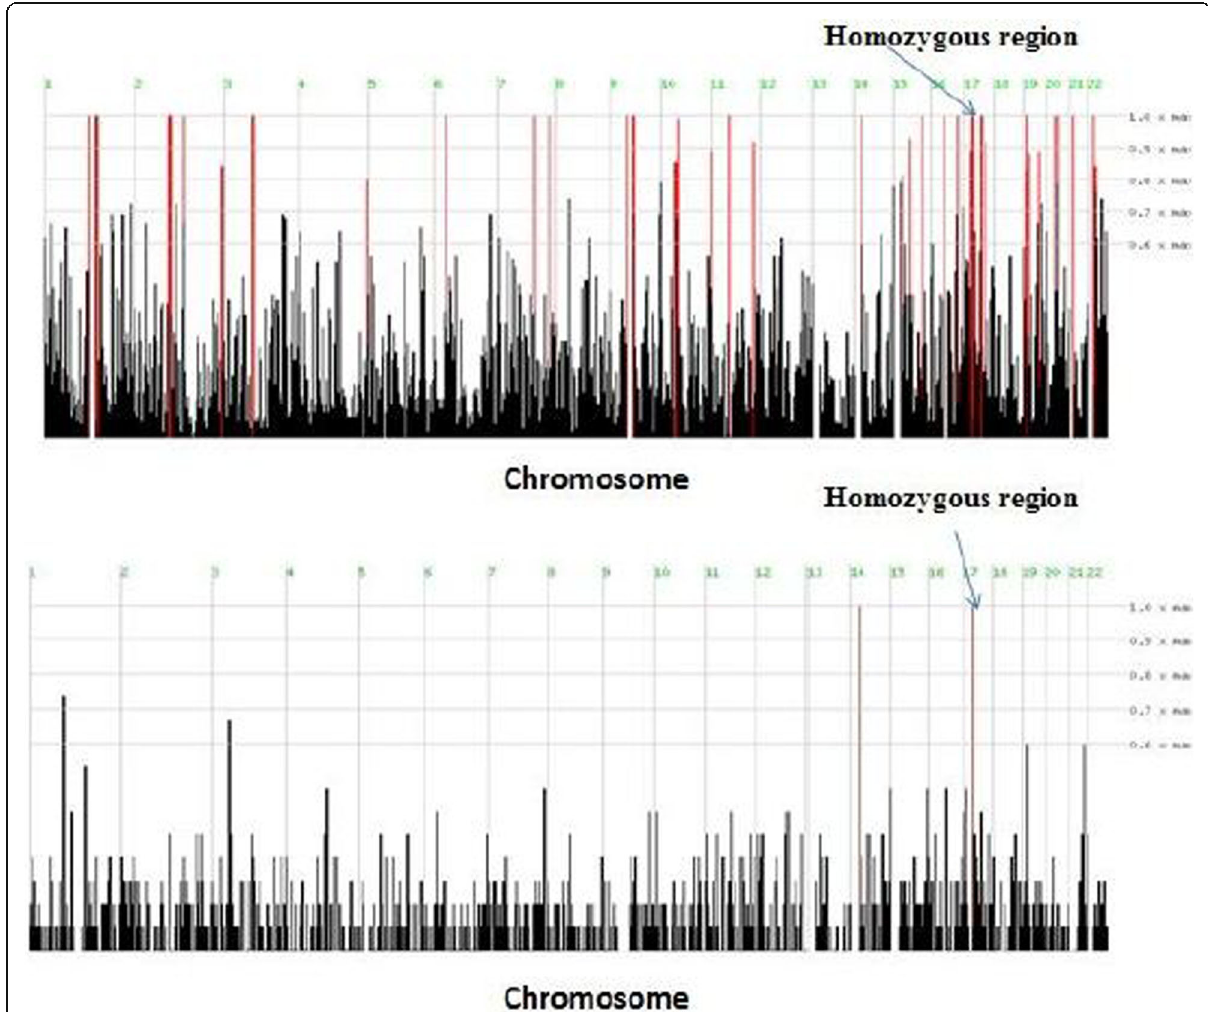
Fig. 2 Genome-wide homozygosity mapping with significant homozygous regions on chromosome 17 marked in red for both ( a ) VSD cases and ( b ) TOF cases. The homozygosity region is present in chromosome 17 revealed for CHD manifestation.